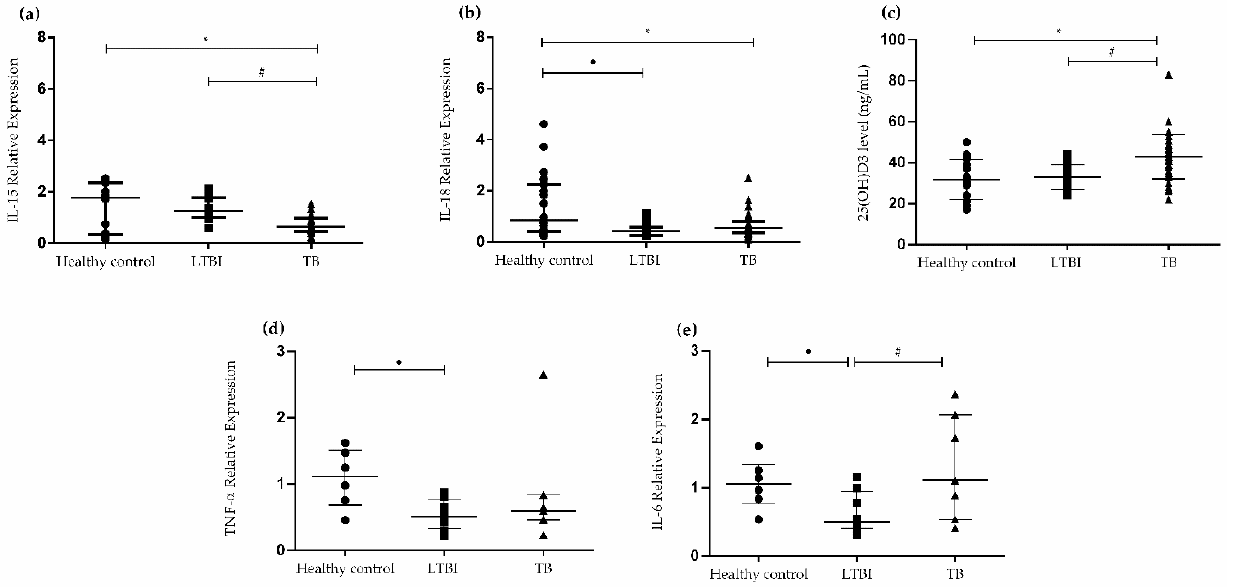
Figure 1. Cytokine gene expression in peripheral blood mononuclear cells (PBMCs) and serum 25(OH)D 3 levels in patients with active tuberculosis (TB), individuals with latent tuberculosis infec- tion (LTBI), and healthy controls. ( a ) IL-15 mRNA expression levels in PBMCs of patients with TB, individuals with LTBI, and healthy controls. * p = 0.0016 for healthy control versus TB; # p < 0.0001 for LTBI versus TB. ( b ) IL-18 mRNA expression levels in PBMCs of patients with TB, individuals with LTBI, and healthy controls. • p = 0.0202 for healthy control versus LTBI; * p = 0.0021 for TB versus healthy control. ( c ) Vitamin D levels were assessed for patients with TB, individuals with LTBI, and healthy controls. * p = 0.0006 for TB versus healthy control; # p = 0.0052 for TB versus LTBI. ( d ) Expression levels of TNF- α mRNA in PBMCs of patients with TB, individuals with LTBI, and healthy controls. • p = 0.0104 for LTBI versus healthy control. ( e ) Expression levels of IL-6 mRNA in PBMCs of patients with TB, individuals with LTBI, and healthy controls. • p = 0.0371 for LTBI versus healthy control; # p = 0.0397 for TB versus LTBI. Data are presented as the mean ± standard deviation (SD) and represent one of three independent experiments. No statistically significant difference was observed between LTBI versus TB for IL-18 and TNF- α ; and healthy control versus LTBI for IL-15 and vitamin D. Statistical analysis was performed using analysis of variance (ANOVA) and post hoc t -test, with a significance of p < 0.05. Abbreviations: LTBI, latent tuberculosis infection; TB,